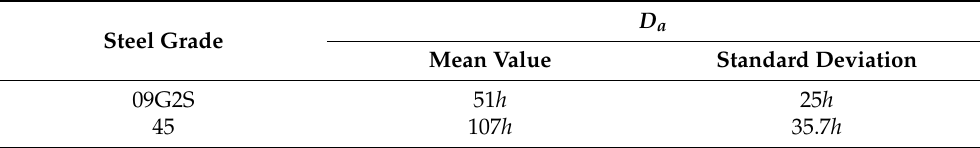
Table 2. Parameters D a distributions for steels under study.